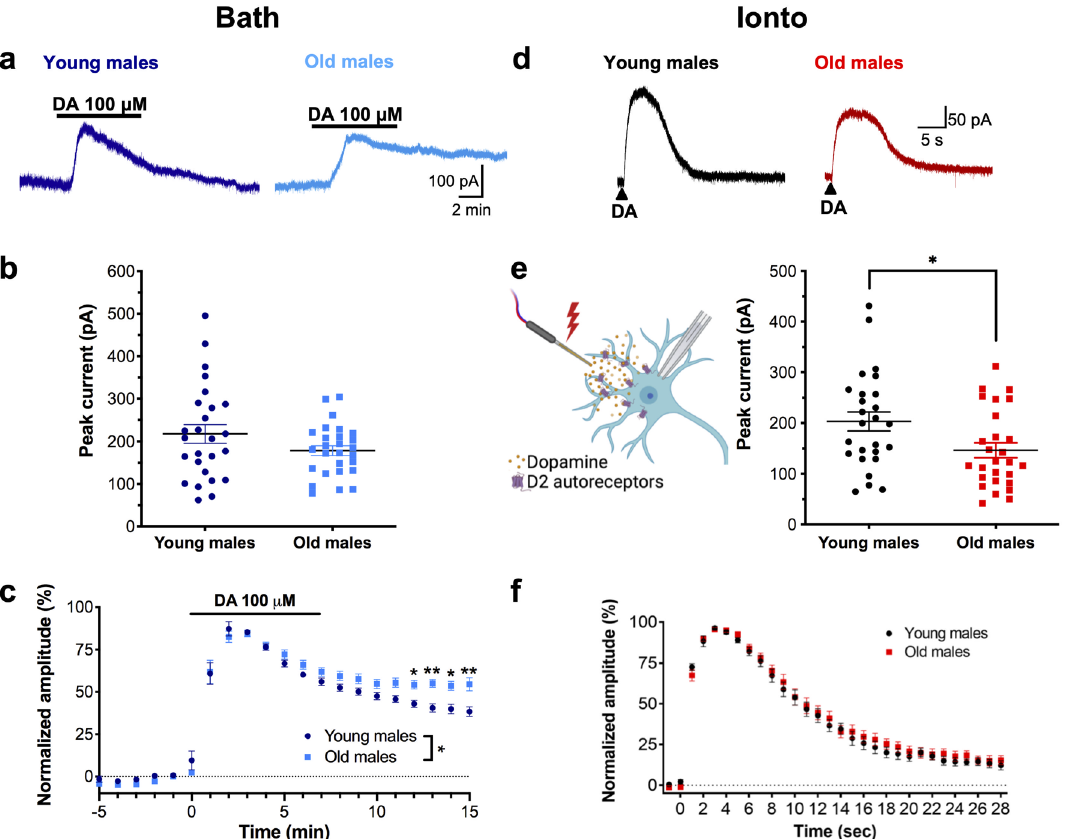
Figure 2. Outward currents in response to exogenous dopamine are reduced in old males. ( a ) Representative traces of D2 receptor mediated currents elicited by bath-application of 100 µM dopamine (DA) for 7 min (horizontal line) from a young (left dark blue trace) and an old mouse (right light blue trace). ( b ) Peak currents from individual cells. Old males tended to have smaller peak currents compared to young males, but this did not reach significance. ( c ) Normalized time course of current after bath application of 100 µM dopamine shows larger responses from old males during washout when compared to young males. ( d ) Representative traces from dopamine currents from young (left trace, black) and old males (right trace, red) when dopamine was applied by iontophoresis (Ionto). ( e ) Diagram depicting iontophoresis of dopamine (left). Peak values from individual cells indicate significantly smaller currents in cells from old males (right). ( f ) Normalized time course of currents elicited by iontophoresis showed no difference in kinetics between old and young males. * p < 0.05. Diagram was created with